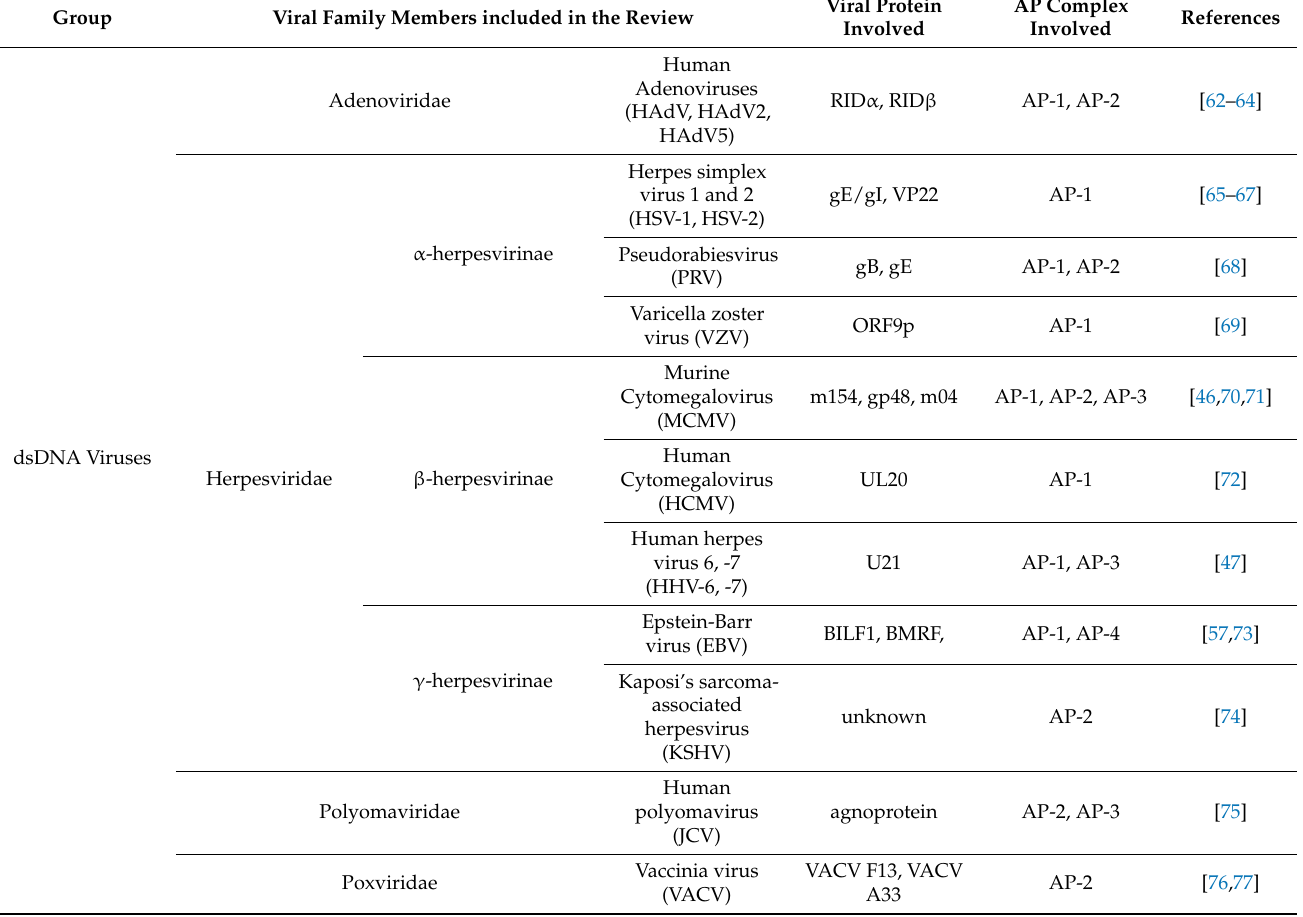
Table 1. Viral families and their respective AP interaction